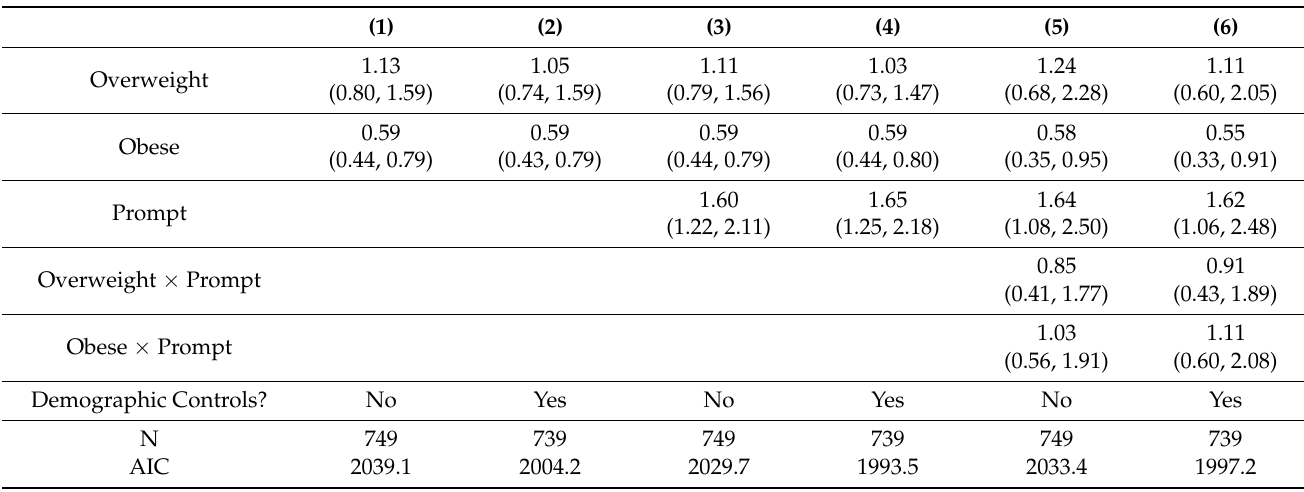
Table A4. Ordinal logistic regression model of choosing a consideration set that contains healthier options. Results represent odds ratios and 95% confidence